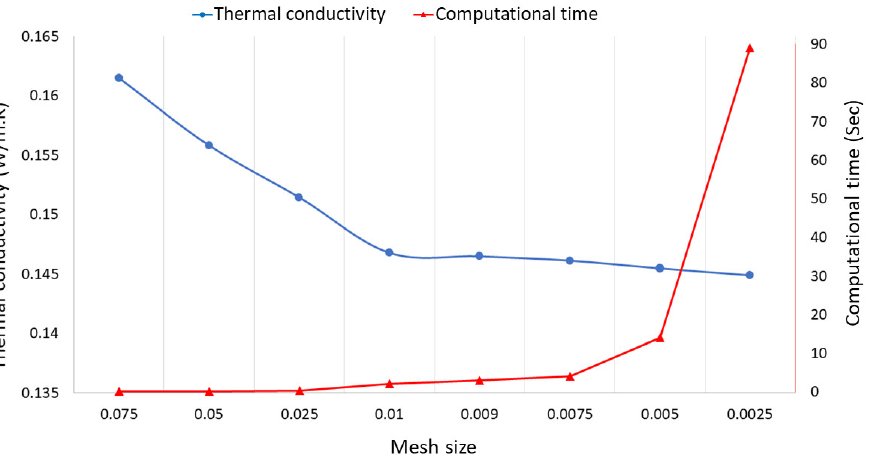
Figure 6. Mesh sensitivity analysis showing variation in the thermal conductivity and computational time versus mesh size.